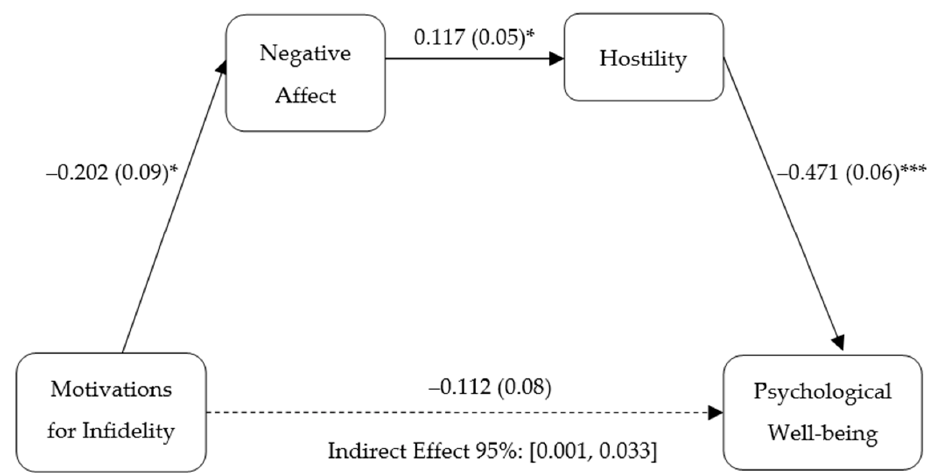
Figure 2. Conceptual model showing the indirect effect of multiple steps between motivations for infidelity and psychological well-being via negative affect and hostility. Unstandardized beta coefficients reported with standard errors within parentheses. Motivations for infidelity: 0 = sexual dissatisfaction, 1 = emotional dissatisfaction. * p < 0.05, *** p < 0.001.